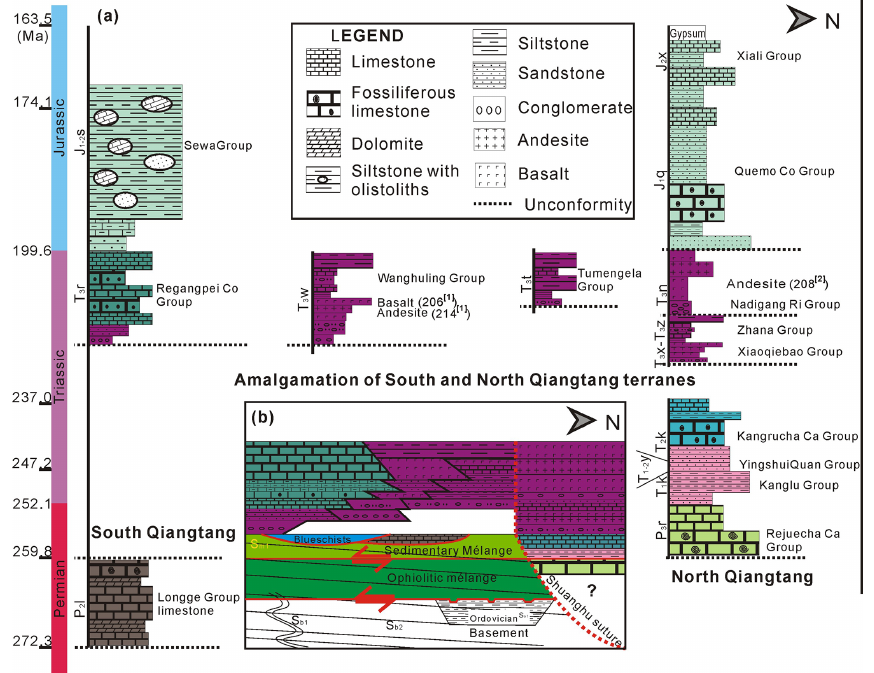
Figure 2. (a) Permian to Jurassic lithostratigraphic columns for the Qiangtang area, from south (left) to north (right); (b) structural and stratigraphic relationships. Basement, ophiolitic mélange and sedimentary mélange with blueschists and Permian sediments form a stack of thrust-bounded sheets. These are unconformably overlain by Late Triassic sediments and volcanics. Sources: (1) Li et al. (2007) and (2) Wang et al.